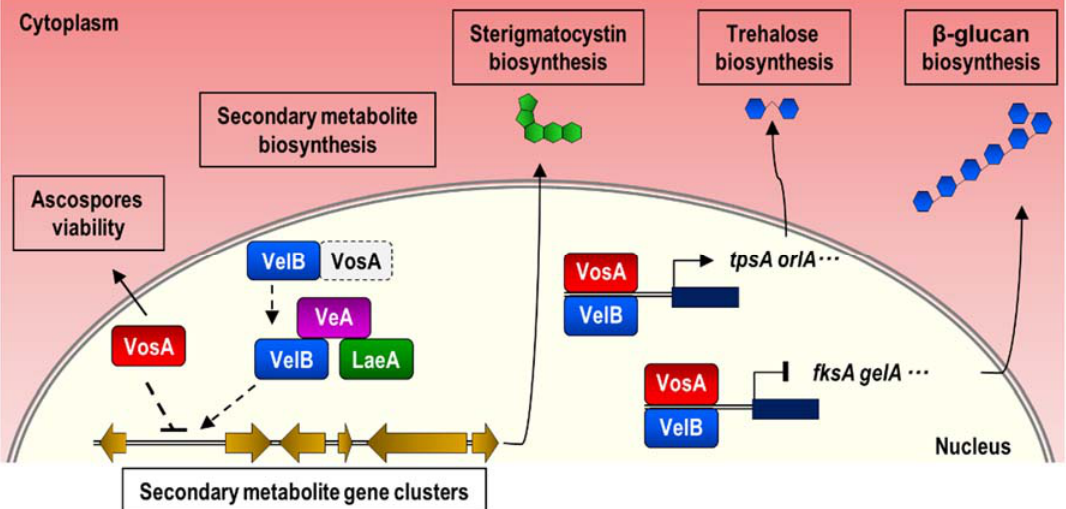
Figure 6. Proposed model depicting the role of VosA during ascosporogenesis. In ascospores, VosA plays a variety of roles during ascosporogenesis. First, VosA is required for ascospores viability. Second, VosA directly or indirectly controls mRNA expression of secondary metabolite gene clusters. Deletion of vosA causes an increase in the number of VelB–VeA–LaeA complexes. Third, VosA (or the VosA–VelB